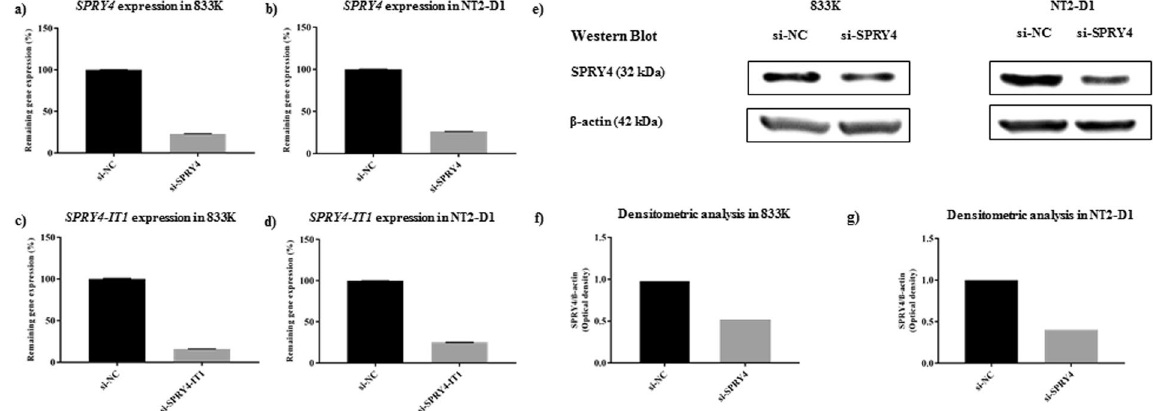
Figure 2. siRNA-mediated knockdown of SPRY4 and SPRY4-IT1 . Knockdown of SPRY4 and SPRY4-IT1 resulted in an average of 75% reduction in RNA expression levels (analysed by qPCR) in both cell lines 833 K ( a , c ) and NT2-D1 ( b , d ). As a vehicle control, a non-targeting negative control siRNA (si-NC) with the same chemical modifications was used. Western blot also showed a considerable reduction of SPRY4 protein expression in both cell lines after the knockdown ( e ). Densitometric analysis of the western blots shows that knockdown of SPRY4 protein was more efficient in NT2-D1 cells ( g ) than in 833 K cells ( f ) OD of SPRY4 was normalized to OD of β -actin. The cropped blots are used in the figure, and full-length blots are presented in Supplementary Fig. S2. The experiments were repeated at least three times, and a representative experiment is shown. t -test: Control vs siRNA, mean ± SD, statistical significance p < 0.05.